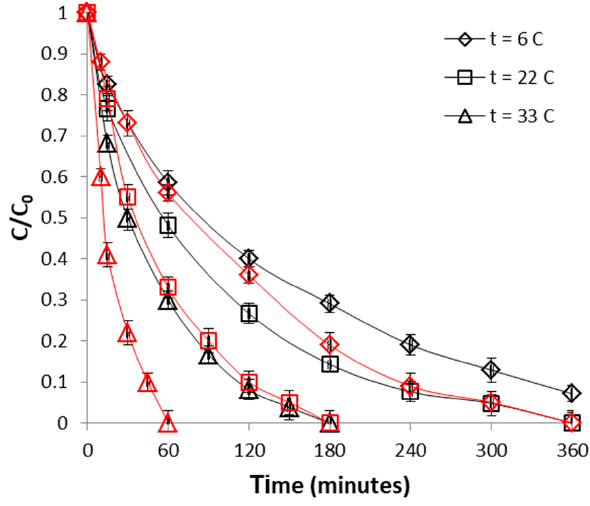
Figure 11. Effect of temperature on Cr VI removal by WSP-Fe 0 (red curves) and WSP (black curves). The lines are not fitting models; they simply connect points to facilitate visualization.